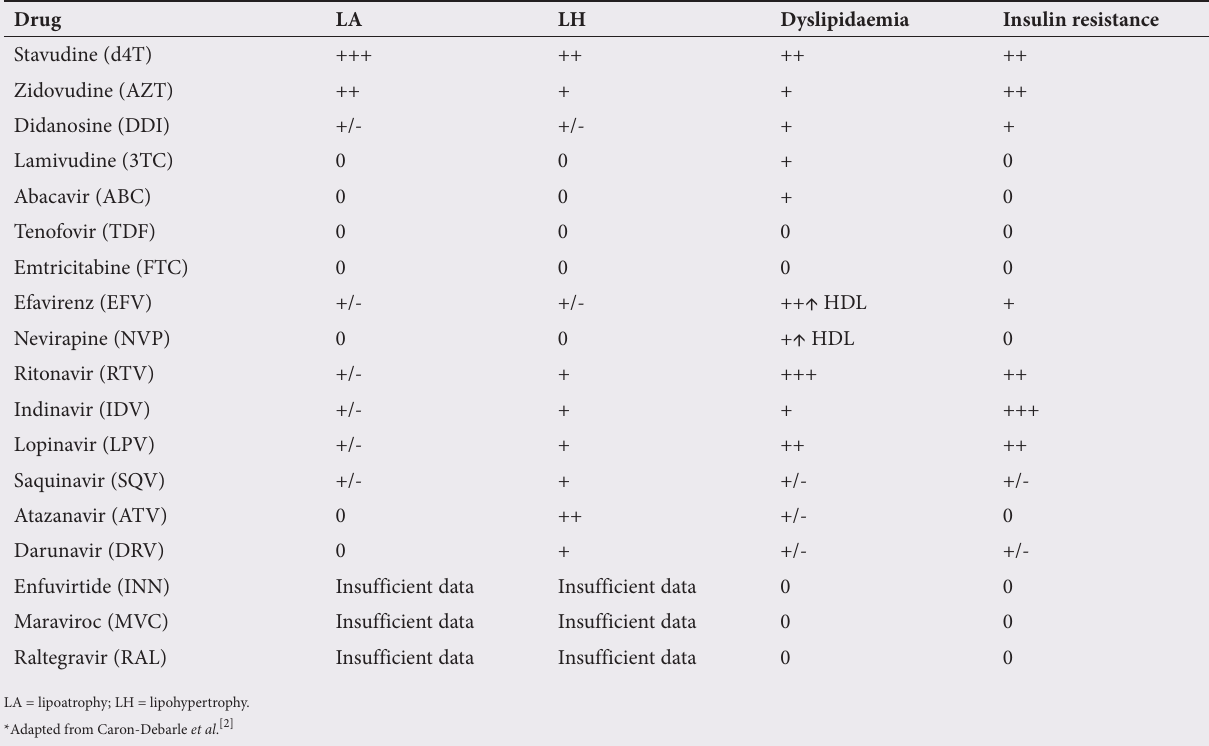
Table 1. The effects of different ARV drugs on fat and metabolism*